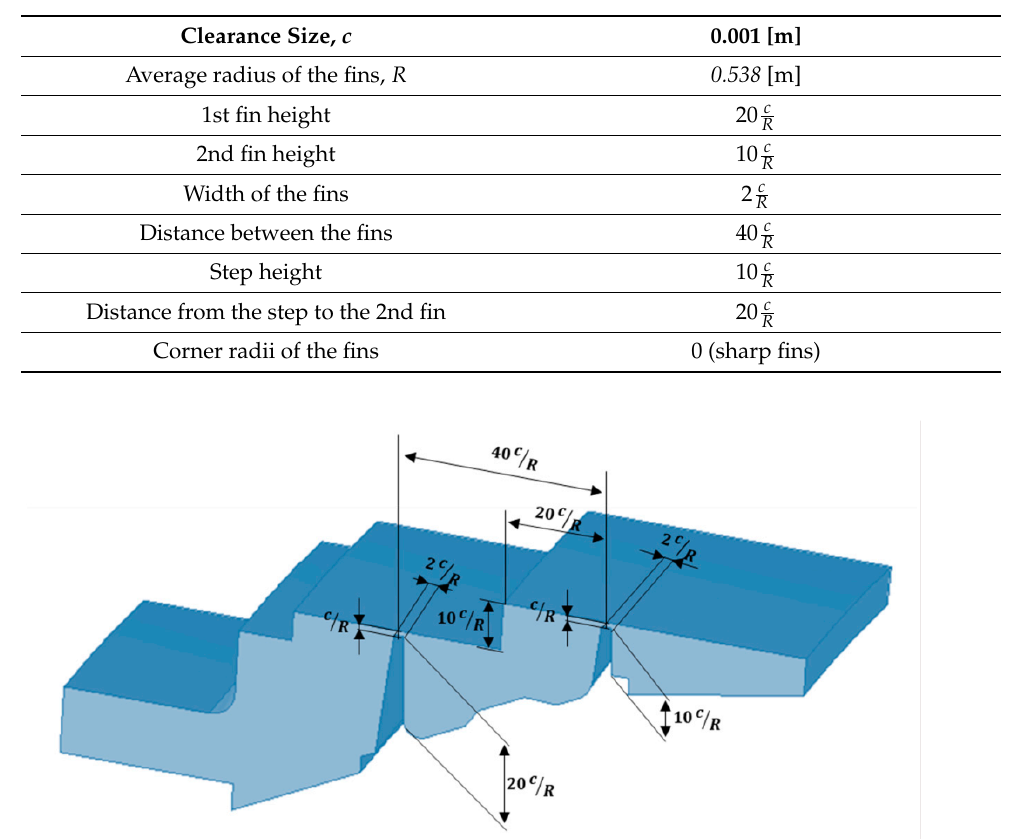
Figure A1. Geometrical details of the outer air seal investigated in the